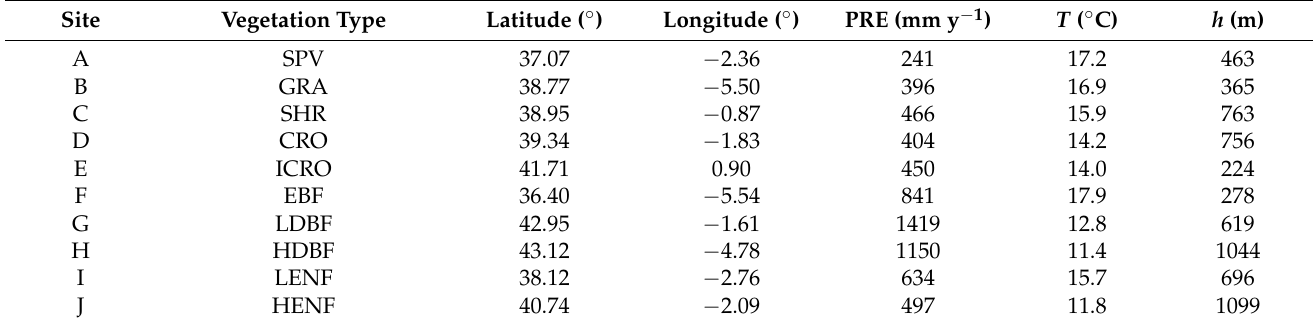
Table 1. Vegetation type, main ecoclimatic features, and coordinates of the ten selected sites with their average annual precipitation (PRE), average annual T , and elevation above sea level ( h ). SPV (sparse vegetation), GRA (grasslands), SHR (shrublands), CRO (rainfed croplands), ICRO (irrigated crops), EBF (evergreen broadleaved forest), LDBF (low-altitude deciduous broadleaved forest), HDBF (high-altitude deciduous broadleaved forest), LENF (low-altitude evergreen needle-leaved forest), and HENF (high-altitude evergreen needle-leaved